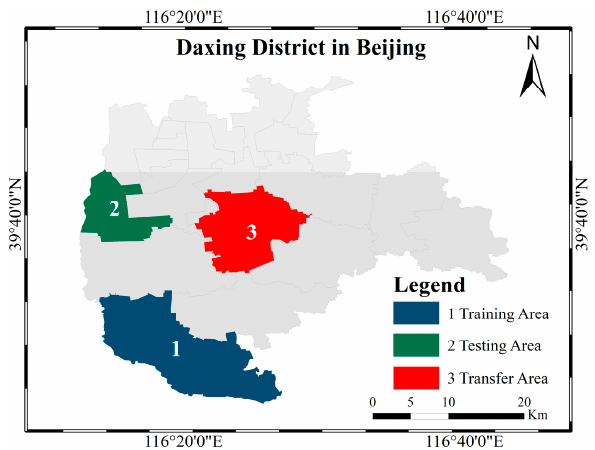
Figure 1. The study areas in Daxing. The coordinate system is